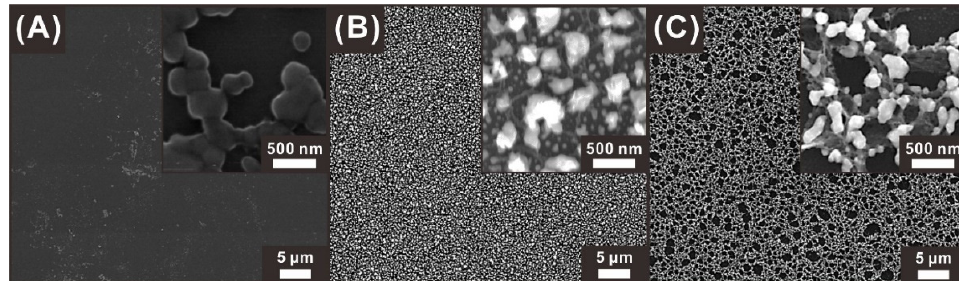
Figure 6. SEM images of ( A ) BC, ( B ) PC, and ( C ) HPC electrodes with the electrodeposited heavy metal alloys (Cd, 10 mg L –1 ; Pb, 10 mg L –1 ; Bi, 400 μ g L –1 ). metal alloys (Cd, 10 mg L − 1 ; Pb, 10 mg L − 1 ; Bi, 400 µ g L − 1